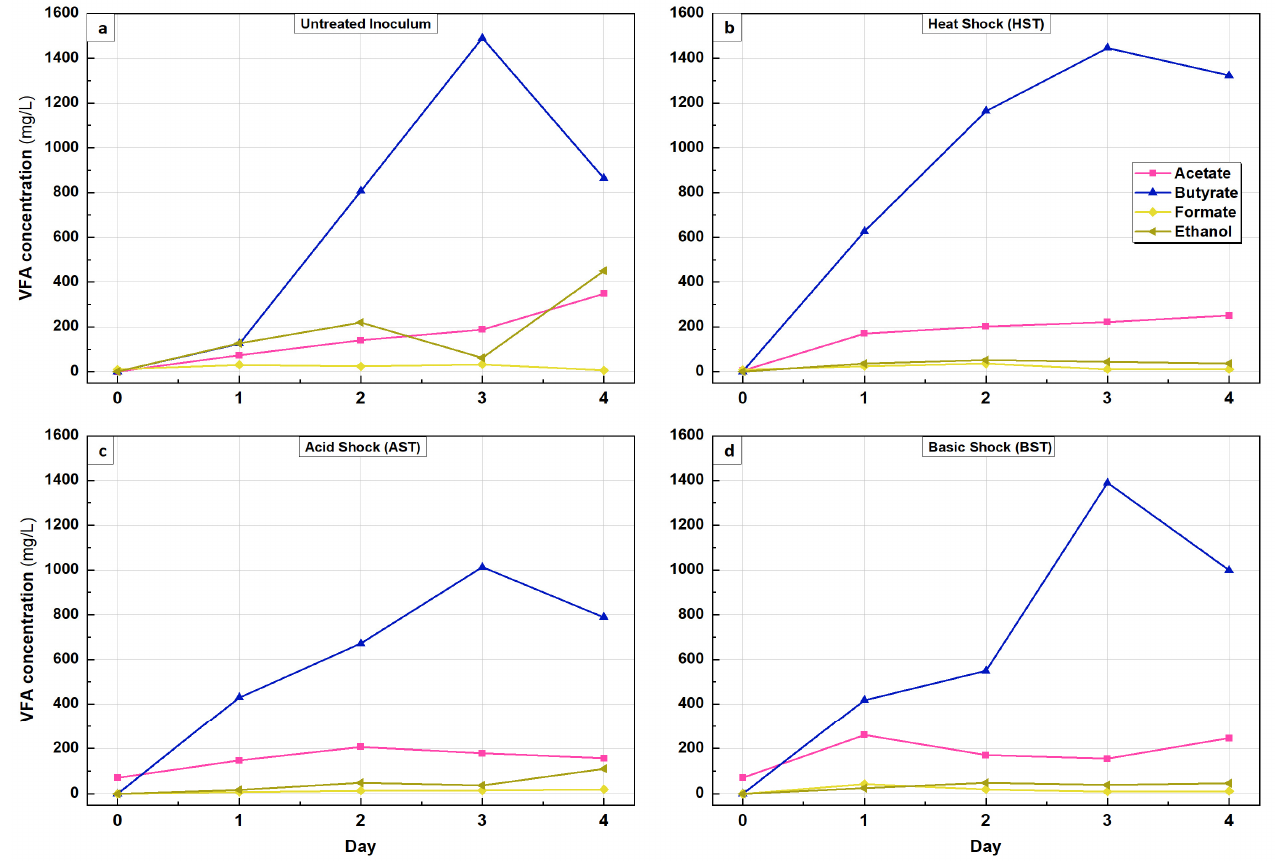
Figure 5. VFA accumulation during 5-day BHP tests: ( a ) untreated inoculum, ( b ) HST, ( c ) AST and ( d ) BST.